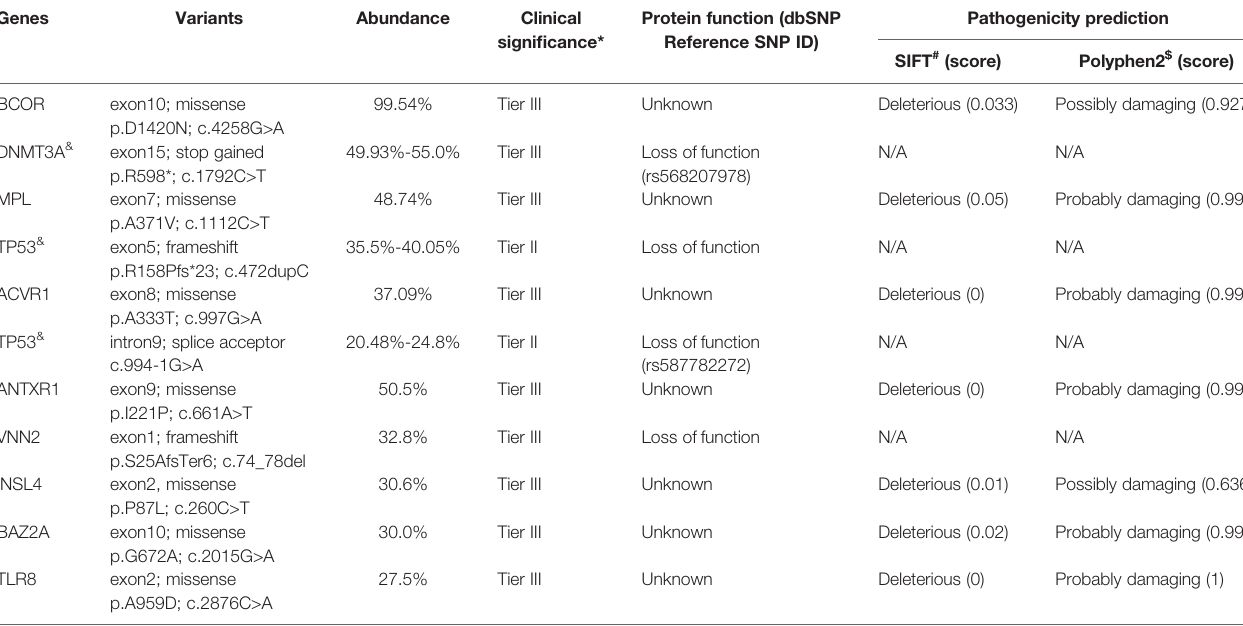
TABLE 1 | The likely pathogenic variants identi fi ed in cervical spine and thoracolumbar